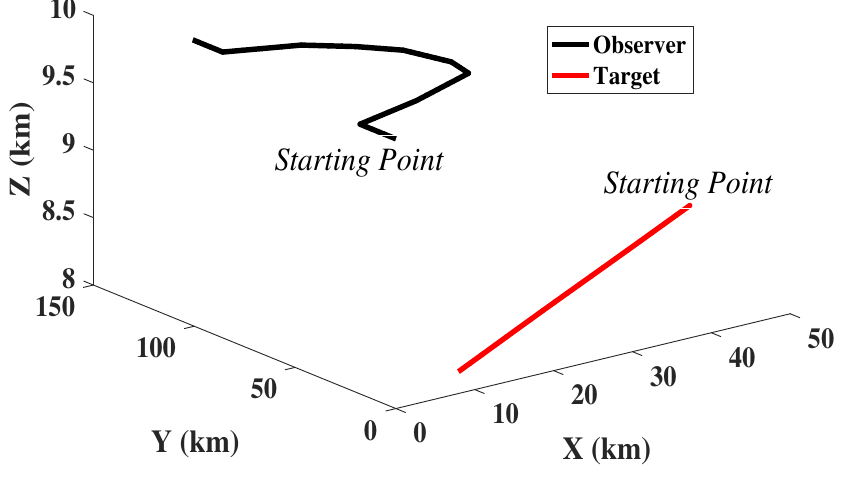
Figure 2. Target Observer Dynamics in